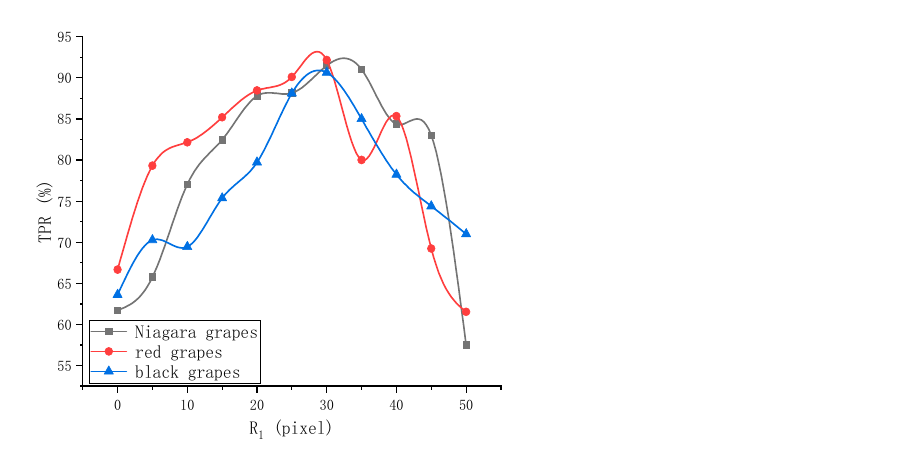
Figure 11. Effect of different R 1 on grape pulp detection. R 1 is the fuzzy search range near the marked centroid point. Table 2. Comparison of detection results of different methods on various grape berries.